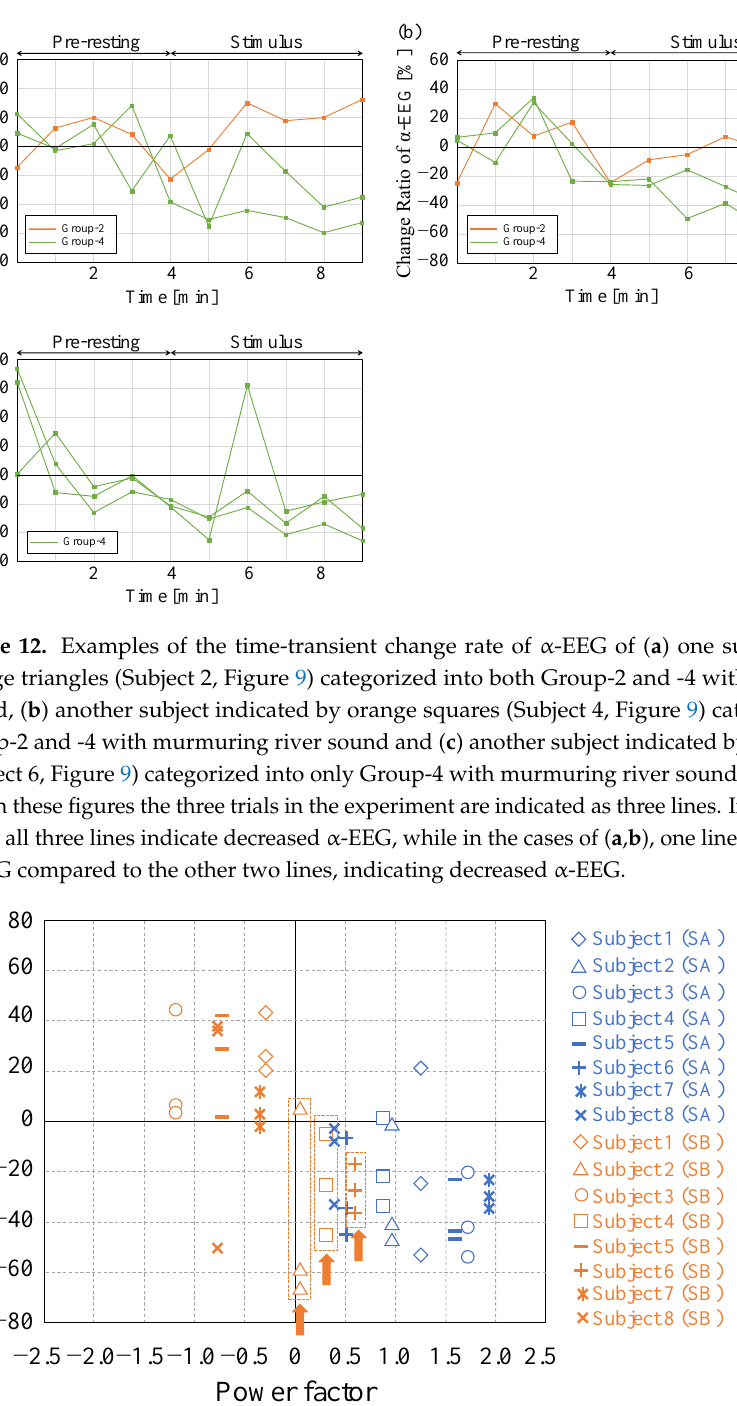
Figure 13. Relationship between the change ratio of α -EEG and the factor scores of power. Each marker indicates the same subjects as those in Figure 9. Each odatum includes two types of sound sources (SA and SB) and three experiments with eight subjects. Blue plots indicate scores for SA (white noise), while orange plots indicate scores for SB (murmuring river sound).